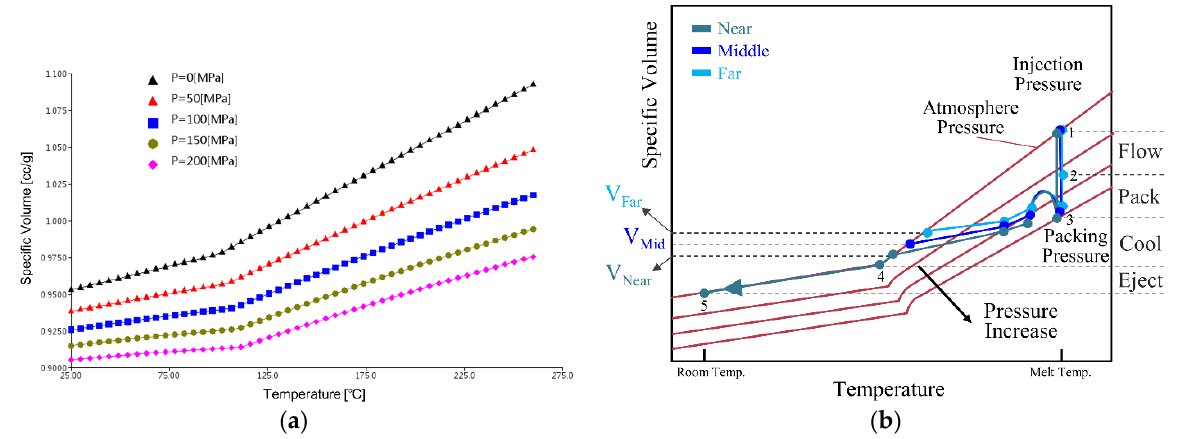
Figure 1. ( a ) PVT graphs for ABS PA756 and ( b ) PVT processing path for the entire injection molding process.